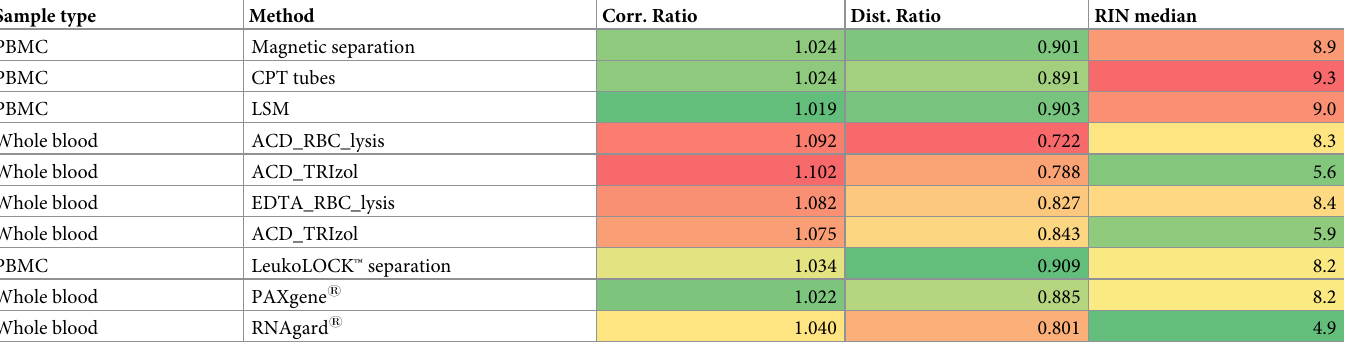
Table 2. Overview of correlation ratio, distance ratio, and RIN medians. Red denotes more favorable values (high RIN; low distance ratio; high correlation ratio) while green denotes less favorable values. The sample type refers to whole blood and PBMCs and method explains the RNA isolation procedure and/or PBMCs separation